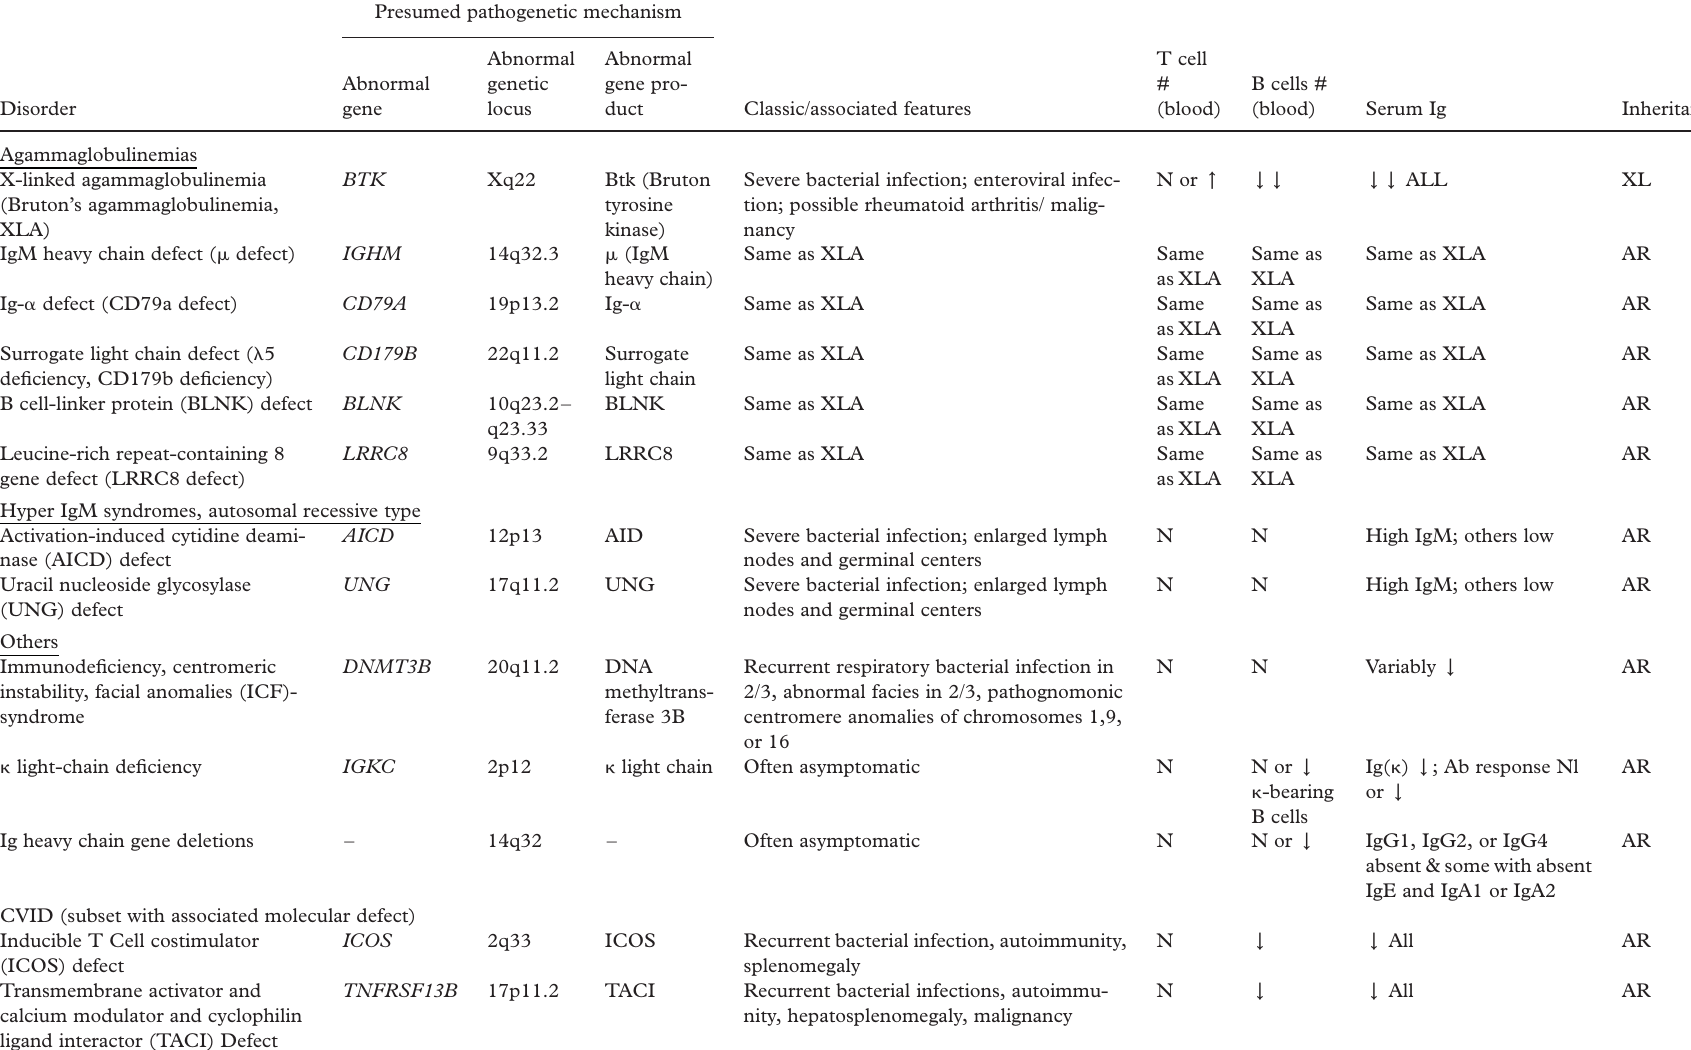
Table I. Humoral